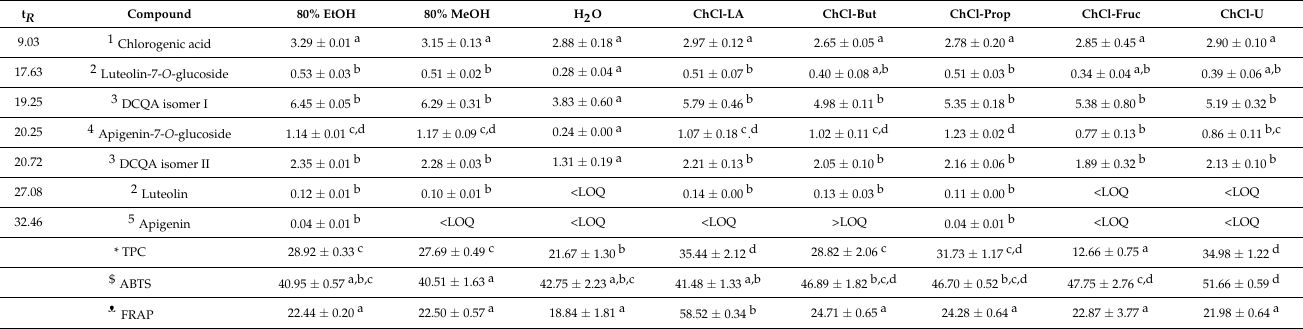
Table 2. The content of individual phenolic compounds (mg g − 1 DW) of A. millefolium in the extracts obtained with five different NADES (25% water) compared with 80% EtOH, 80% MeOH, and water. The results are expressed as mean value ± standard